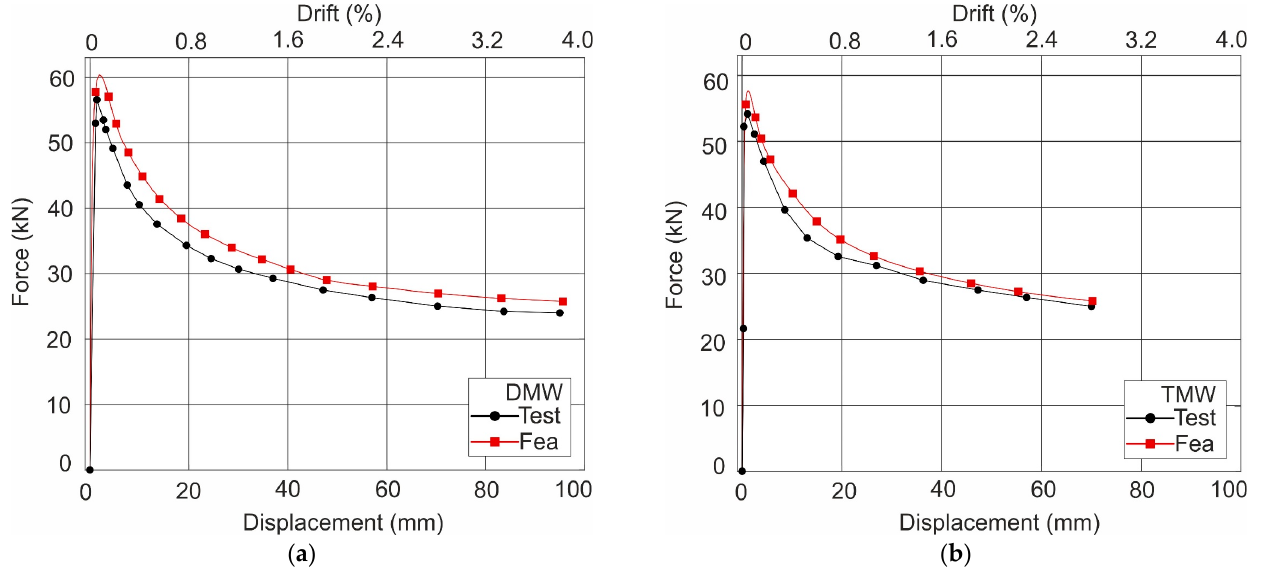
Figure 10. Experimental and numerical load–drift curves for ( a ) DMW and ( b ) TMW. Experimental cracks and the maximum principal strains (PE) obtained by the numerical model of DMW are compared in Figure 11. Since the models representing the mortar jointed specimens showed similar results, only the plots for the DMW model are evaluated in detail. The crack distributions of the DMW obtained in the tests are drawn for the three top drifts associated with the Damage Limitation (DL: 0.4% top drift), Severe Damage (SD: 1.2% top drift), and the Near Collapse (NC: 3.2% top drift) limit states in Figure 11a–c. The dashed lines in the figures show the damage on the inner face of the wall. The results show that the regions with large strains, shown in Figure 11d–f, can be associated well with the experimental crack distribution. Although the stepped cracks following the edges of